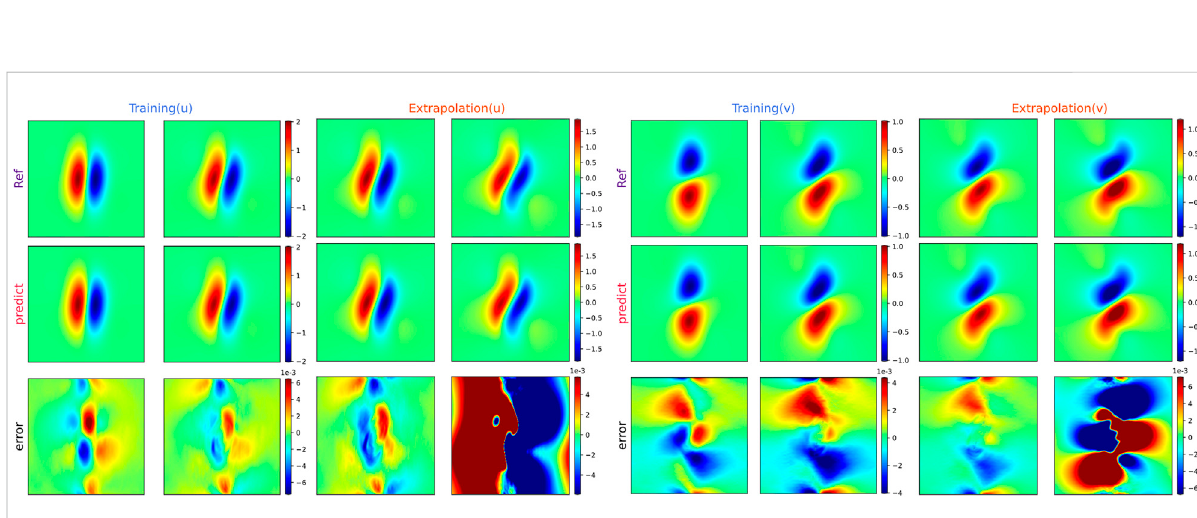
and velocity fi elds are close to the true reference during the training and extrapolation phases. Especially in the training phase, many errors are close to zero. As the extrapolation